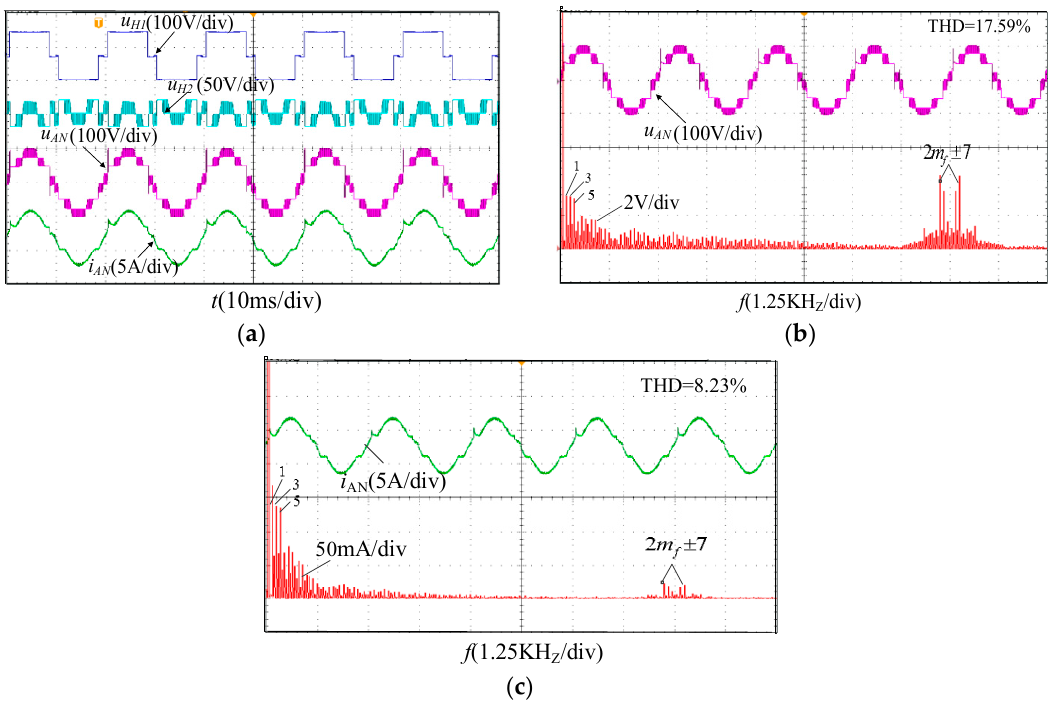
Figure 11. Experimental waveform of HF-PWM. ( a ) Output voltage and current waveform. ( b ) u AN and harmonic spectrum. ( c ) i AN and harmonic spectrum.